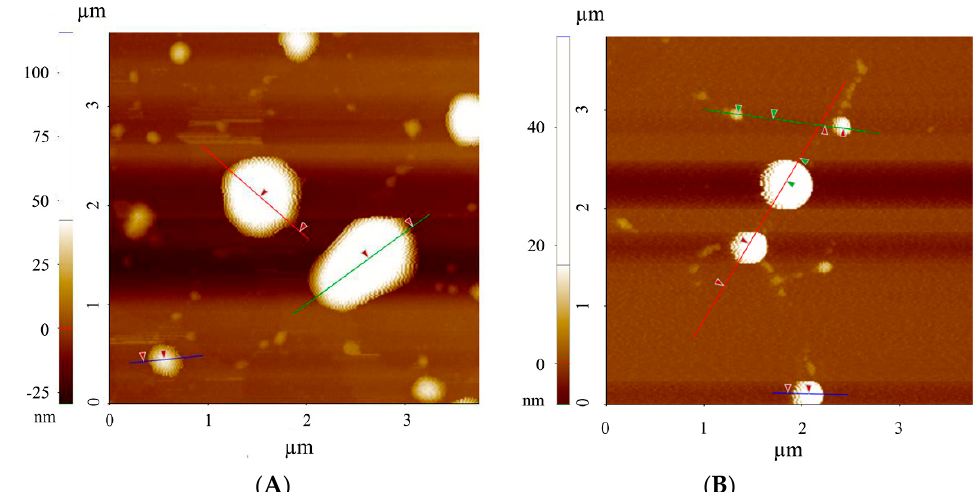
Figure 3. Atomic force microscopy images of ( A ) Blank and ( B ) RFB-loaded NLC. Nanomaterials 2020 , 10 , x FOR PEER REVIEW